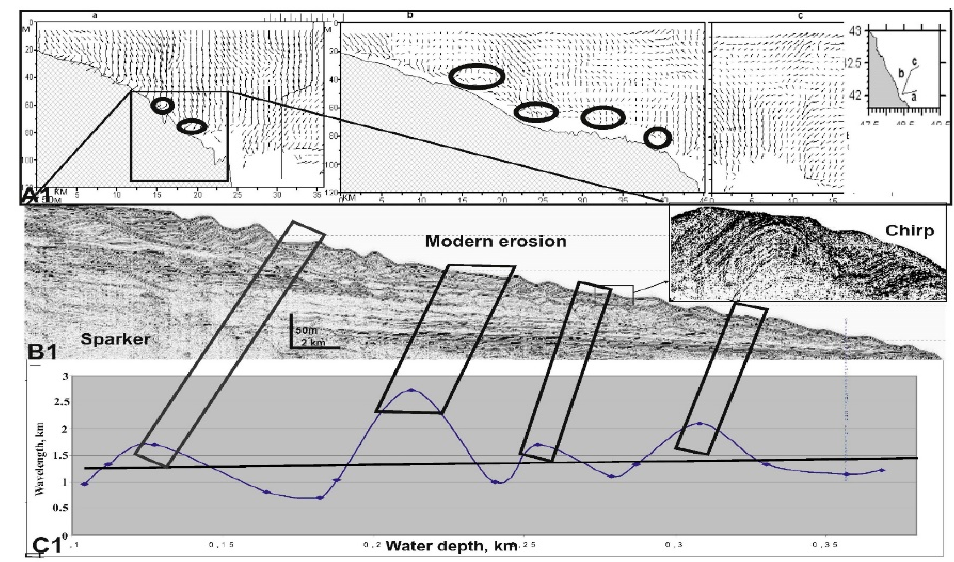
Figure 16. Modern erosion and resuspension on upper part of the western slope (sediment waves field, Figure 5A). Wavelength—Water depth relation, sinusoid, and linear trend ( C1 ) correlated with hydrophysical profile ( A1 ) and sparker section ( B1 ) (seismic from Figure 5A). Circles for current branches. Details of modern erosion are shown on Chirp data (sweep seismoacoustic signal, inset). SW Type 2. Several fields of wavy features exist on the Mangyshlak Sill (Figures 7 and 17). These features are interpreted as channel levee sediment waves migrating toward the channel. The sediment waves on levees are believed to have formed by classic outspill on channel meanders [57].